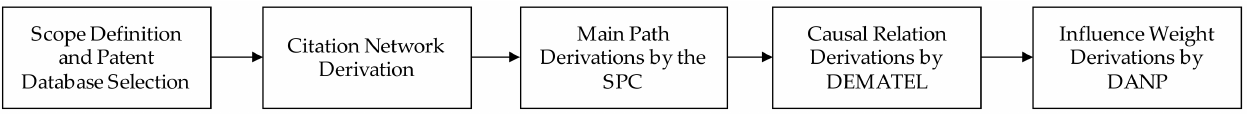
Figure 1. Analytic